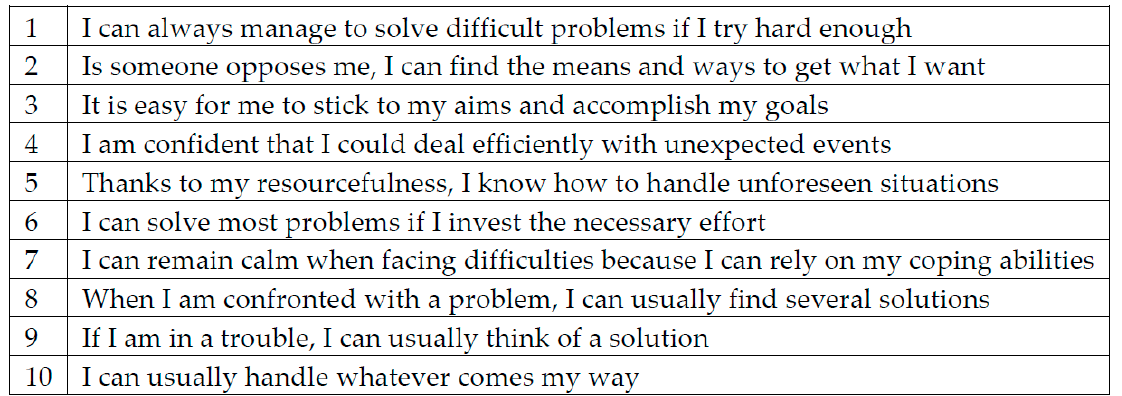
ffi cacy Scale by Baessler and Figure 1. General Self-Efficacy Scale by Baessler and Schwarzer. Figure 1. General Self-E